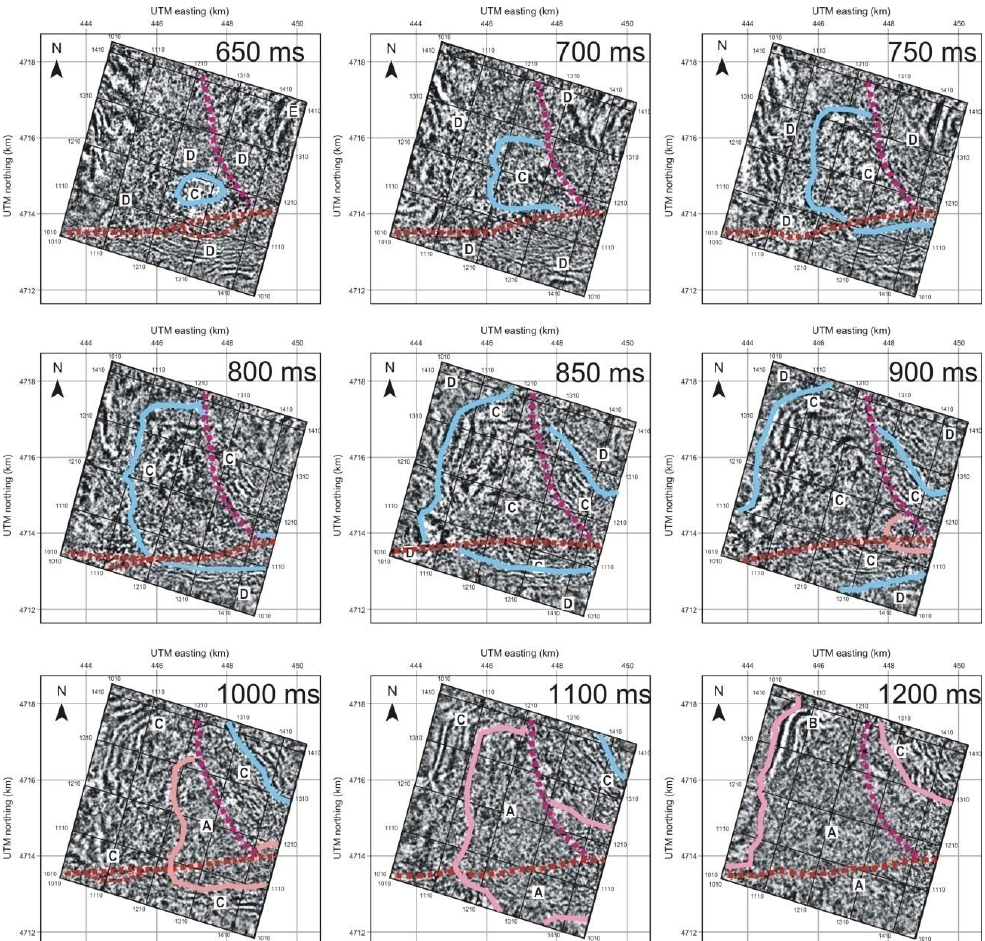
Fig. 13. Time slices from the migrated seismic volume with the different seismic reflection sets (A to H) recognized. The blue line (observed from time slice 900 to 650ms) represents the top of the Jurassic dome structure (probably the top of the Purbeck Fm.). The pink line represents the base of the Jurassic dome (observed from time slice 1200 to 900ms). Two faults have been interpreted: the Southern fault (red dashed line) and the Eastern fault (magenta dashed line). Note that certain splits of the Eastern fault have been marked in time slices 1000 and 650 ms.